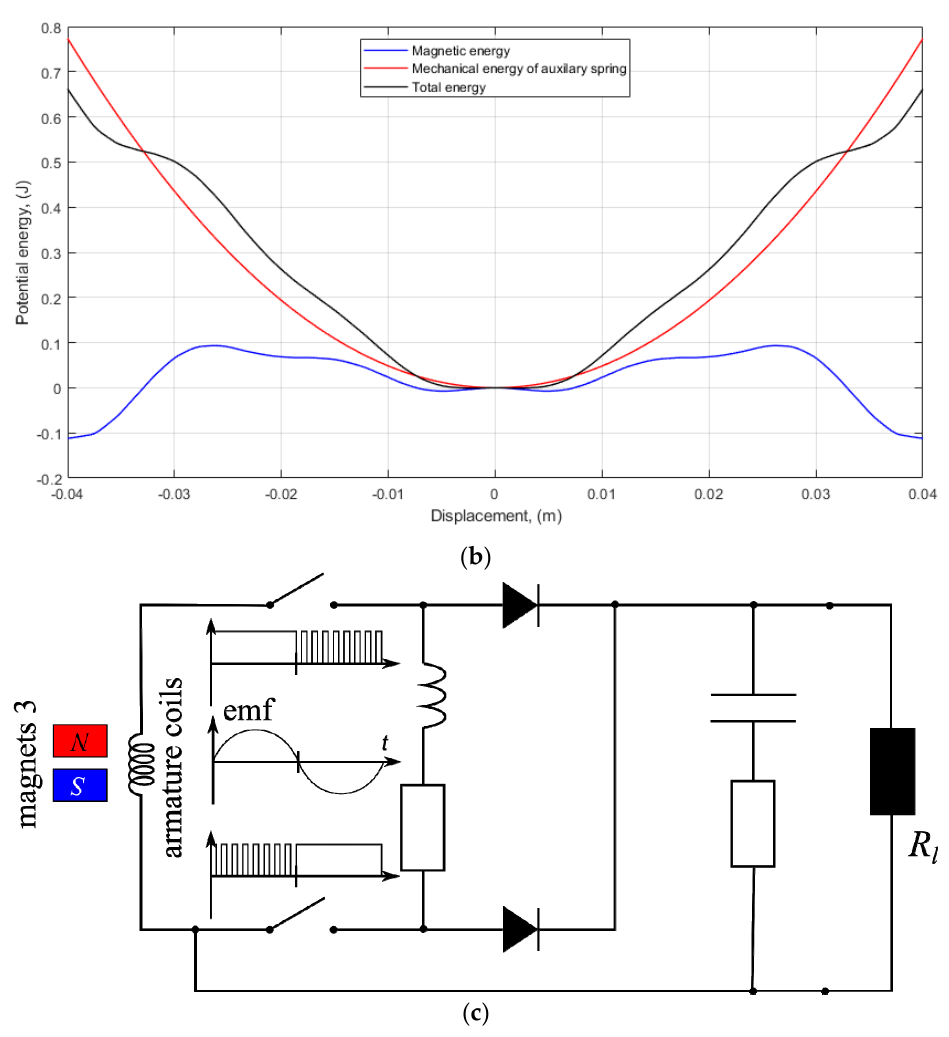
Figure 1. Considered system: ( a ) magnetic circuit of microgenerator—arrows denote magnetization senses of permanent magnets; ( b ) variation of potential energy vs. relative displacement of magnets 3; ( c ) circuit diagram of electronic boost converter [24] loaded by resistor R l .